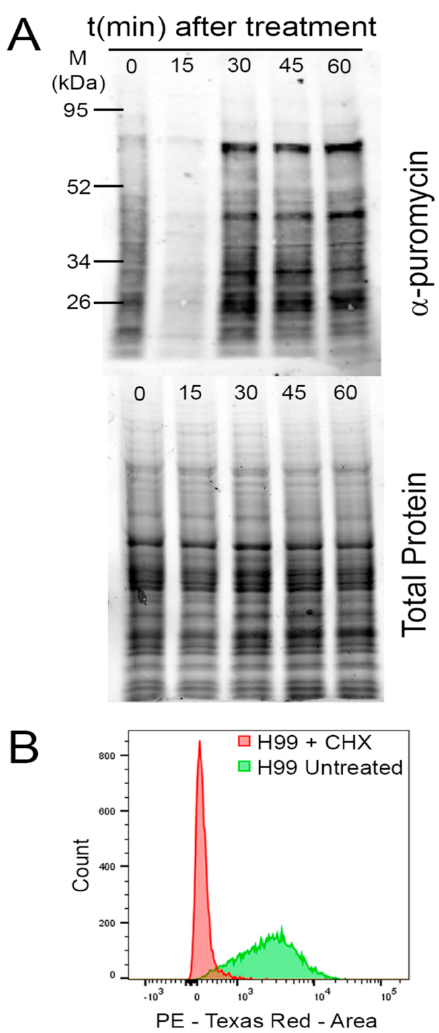
Figure 3. Measuring translational output. ( A ) Top panel: A western blot of whole lysates from representative samples treated with temperature stress for the indicated time, using an α -puromycin antibody to recognize puromycilated peptides, indicative of translational output. Bottom panel: Total protein for normalization of the α -puromycin signal. ( B ) A histogram of flow cytometry results following the click chemistry labeling reaction of incorporated HPG. The histogram in green shows basal levels of translational output while the histogram n red demonstrates inhibition of translational output by cycloheximide (CHX)